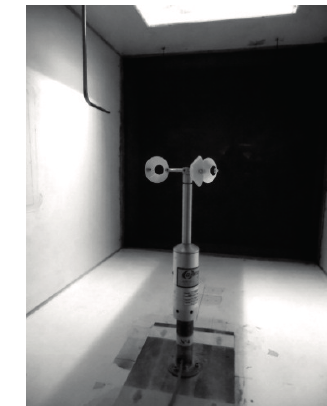
Figure 3. ( Left ) Results from two calibrations performed at the IDR/UPM Institute, on the same cup anemometer (Thies Clima 4.3350) following two different procedures, AC and AD. AC calibrations follow strictly MEASNET procedure (wind speeds ranging from 4 m·s − 1 to 16 m·s − 1 , and 13 measurement points are taken), whereas AD calibrations are carried out over a broader wind speed range (from 4 m·s − 1 to 23 m·s − 1 ) and fewer measurement points are taken (9 instead of 13). The transfer function resulting from the linear fitting to AC calibration data has been included in the graph, together with the coefficient of determination, R 2 ; ( Right ) Cup anemometer equipped with a prototype rotor during the calibration process at the S4 wind tunnel at the IDR/UPM Institute.